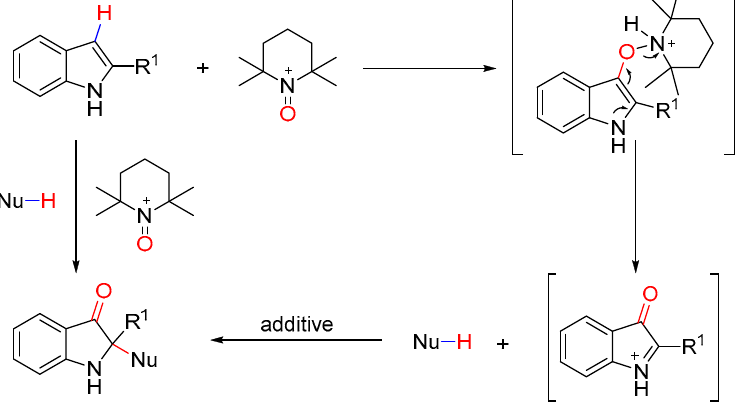
Figure 2. Oxidative dearomative cross-dehydrogenative coupling of indoles with various C-H nucleophiles.